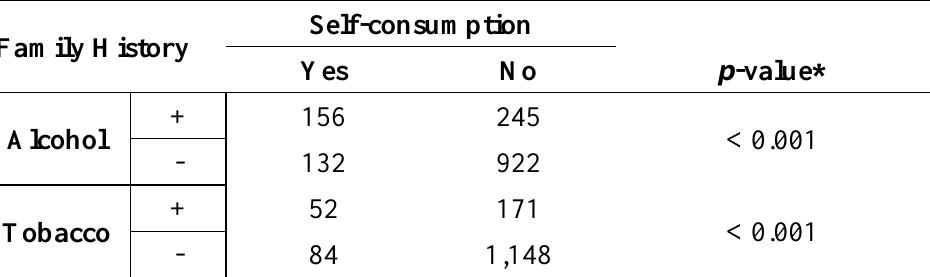
Table 2: Association of a positive family history with consumption of substances among UGs and